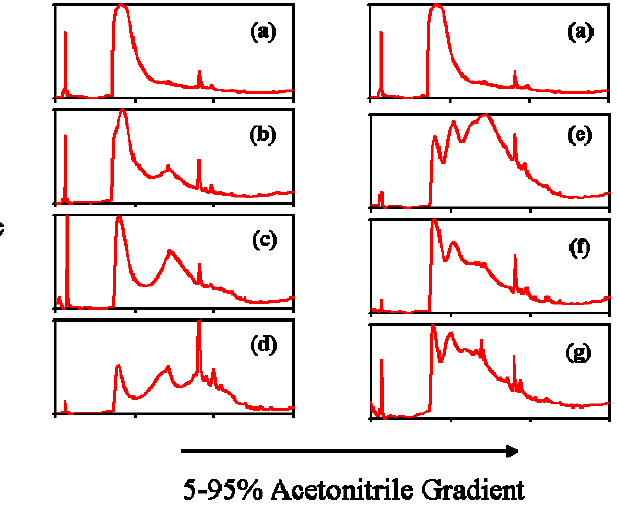
OH unmodified dendrimer 5